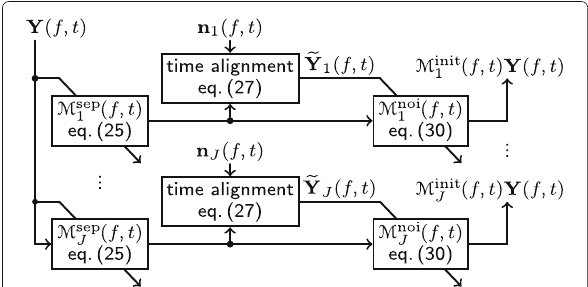
Fig. 3 The noise suppression masks M noi j ( f , t ) are determined based on each of the J outputs of the initial source separation after time aligning the channels for the respective target DOA. The combination of these steps yields the initial masks